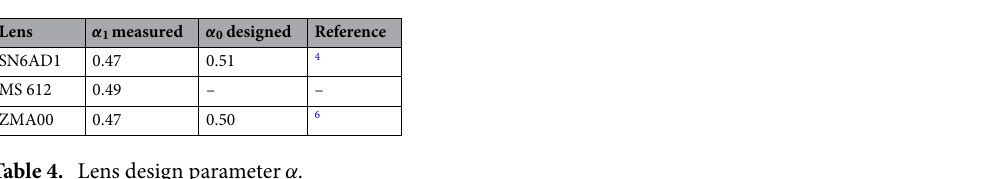
Table 4. Lens design parameter α .